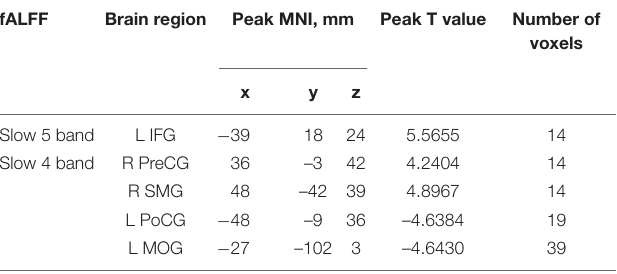
TABLE 3 | Regions revealing significant fALFF differences between IXT patients and HCs ( P < 0.05, corrected for GRF). fALFF Brain region